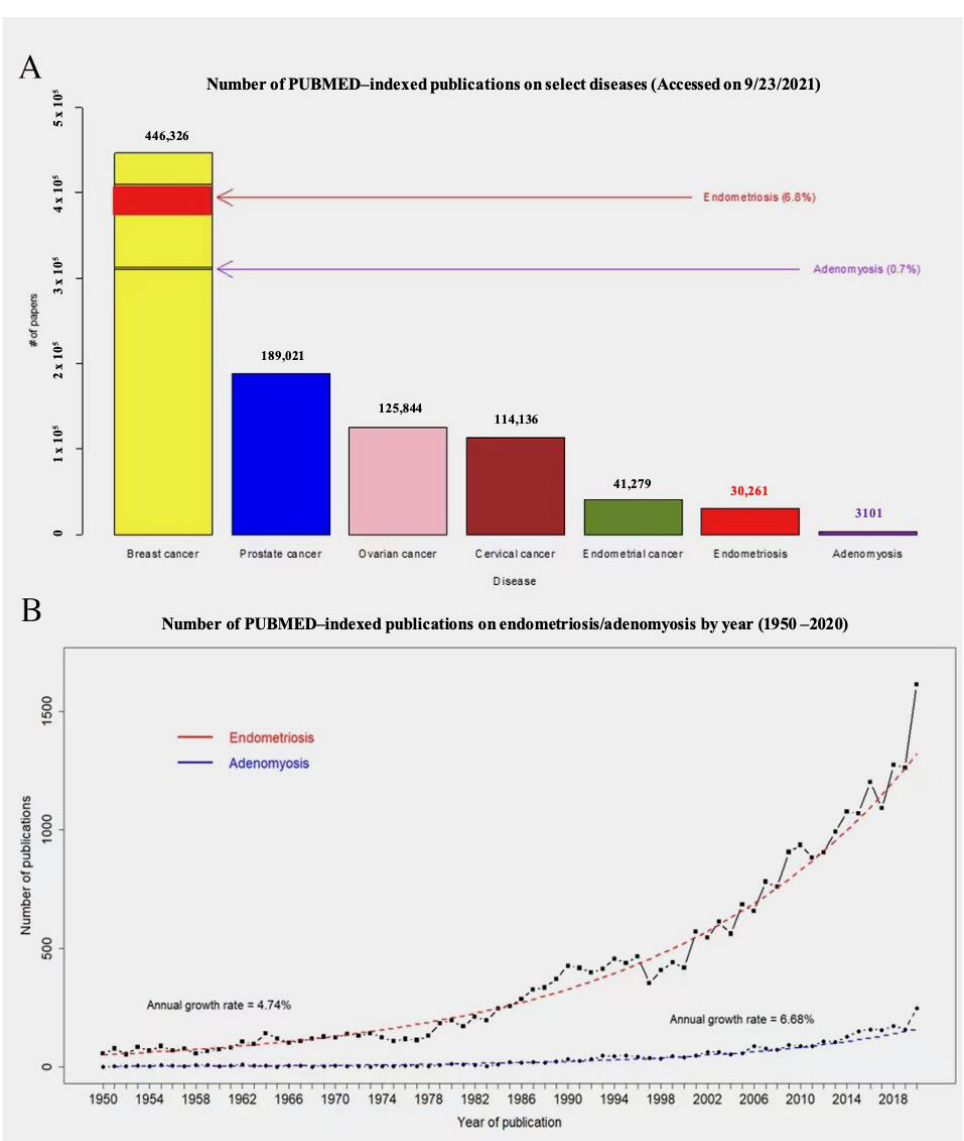
Figure 1 . ( A ) A comparison of the number of PubMed-indexed publications on breast cancer, prostate cancer, ovarian cancer, cervical cancer, endometrial cancer, endometriosis, and adenomyosis (accessed on 9 October 2021). The numbers listed on each bar are the exact numbers of publications. ( B ) The numbers of PubMed-indexed publications on endometriosis and adenomyosis in the last 70 years (1950–2020). The dashed curves are the fitted regression